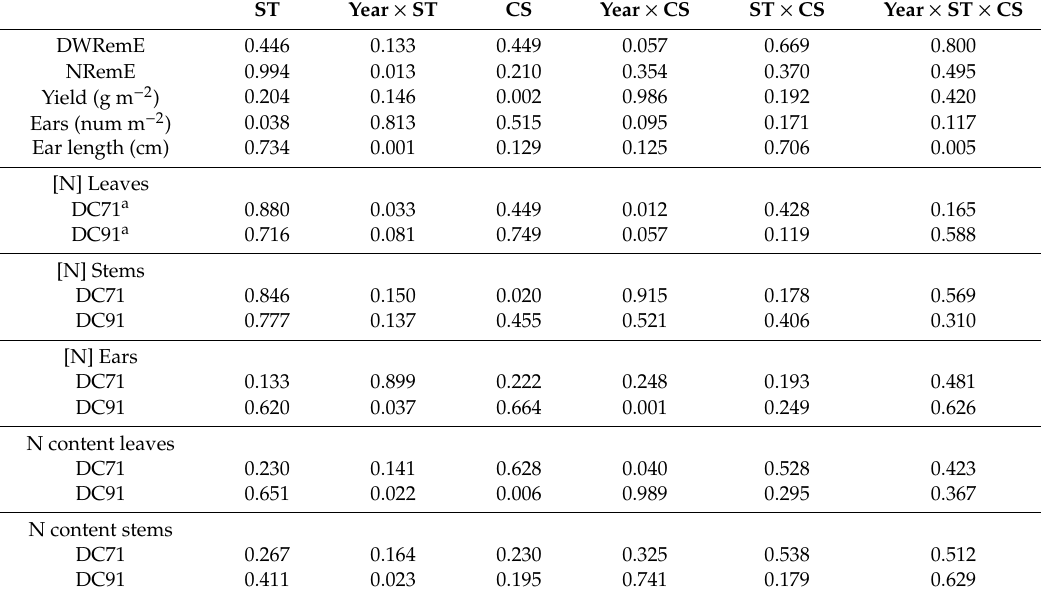
Table 3. Summary of p -values from the analyses of variance for dry weight remobilization e ffi ciency (DWRemE, % of vegetative DW), nitrogen remobilization e ffi ciency (NRemE, % of vegetative N), yield (g m − 2 ), number of ears per square meter (ears, num m -2 ), ear length (cm), N concentrations ([N]) in leaves (g kg − 1 ), [N] in stems (g kg − 1 ), and [N] in ears (g kg − 1 ), N content in leaves (g m − 2 ), N content in stems (g m − 2 ), N content in ears (g m − 2 ), grain protein content (GPC, %), gliadins (Glia, mg g − 1 ), high molecular weight glutenins (HMW-GS, mg g − 1 ), low molecular weight glutenins (LMW-GS, mg g − 1 ), normalized vegetation index (NDVI), green normalized di ff erence vegetation index (GNDVI), soil-adjusted vegetation index optimized (OSAVI), water index (WI) and SPAD. E ff ects: ST, soil tillage; CS, crop sequence. Degrees of freedom: Year, 1; ST, 1; Year × ST, 1; CS, 1; Year × CS, 1; ST × CS, 1; Year × ST × CS, 1; Residual, 8.